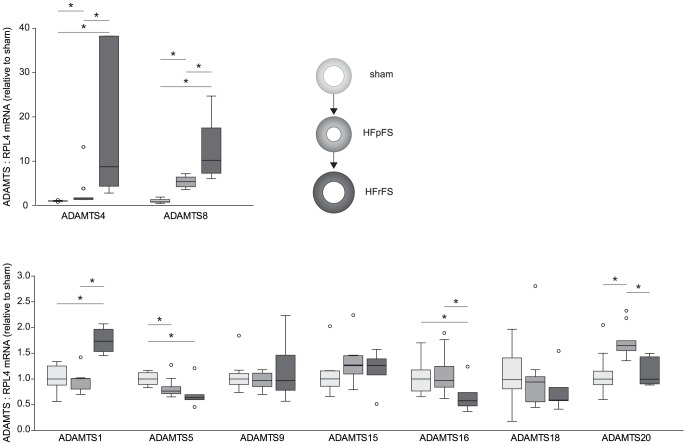
Elevated mRNA levels of ADAMTS1, -4 and-8 in rats after aortic banding.Myocardial mRNA expression of ADAMTS versicanases and aggrecanases in rats with preserved (HFpFS, n = 9) or reduced FS (HFrFS, n = 6) six weeks after AB, normalized to reference gene RPL4 and relative to sham (n = 9). Box-plots show median (horizontal line), interquartile range (box), 1.5xinterquartile range or maximum/minimum range (whiskers) and outliers (>1.5xinterquartile range). *p<0.05. AB, aortic banding; FS, fractional shortening; ribosomal protein L4, RPL4.